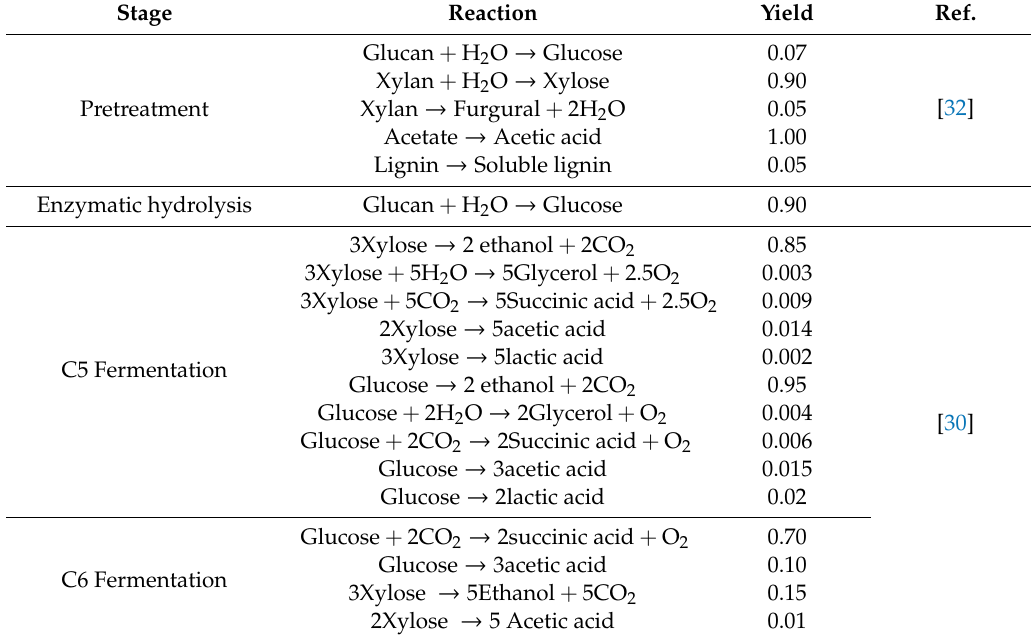
Table 7. Summary of the stoichiometric equations of the main stages for topology 2.